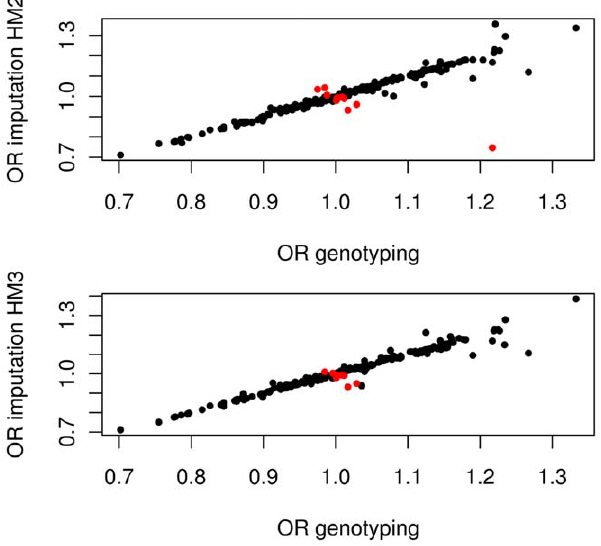
Figure 2. Correlation between effect sizes observed by concomitant genotyping and imputation of candidate gene SNPs for which both measures were available. (red indicates change of effect direction between genotyping and imputation). For the comparison based on HapMapII (HM2) data 241 SNPs and for HapMapIII (HM3) 216 SNPs were available.